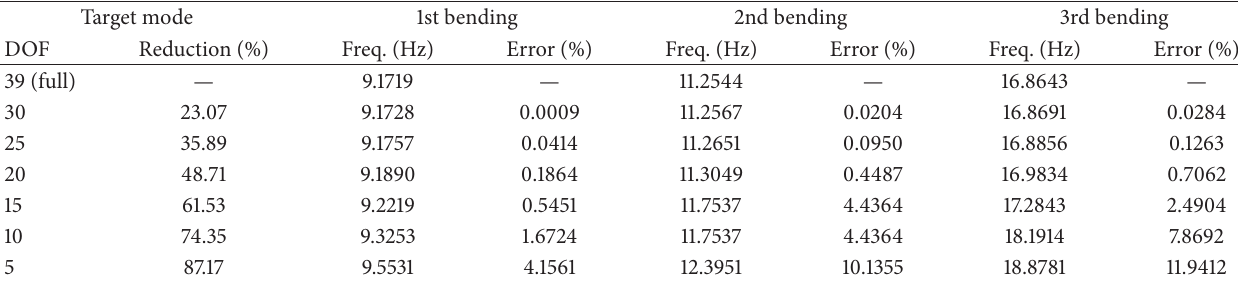
Table 6: FE analysis results per DOF of cable-stayed bridge model using